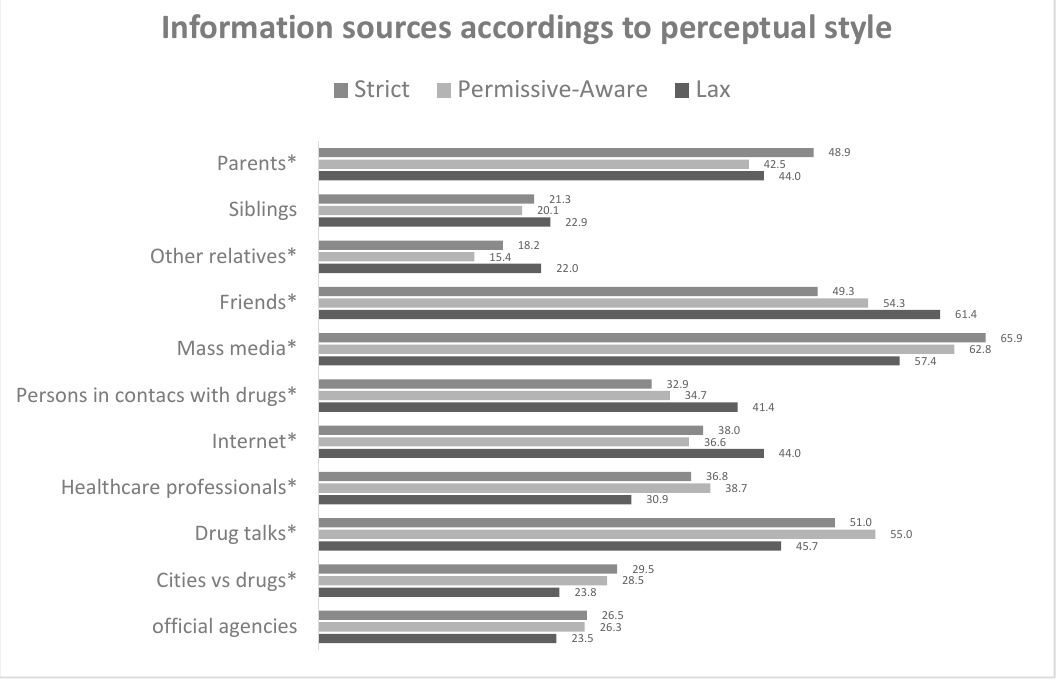
Figure 2. Most frequent information sources from which participants received information about drugs according to perceptual style. The asterisk (*) indicates that there were significant differences in the Chi Square Test ( p < 0 .05).